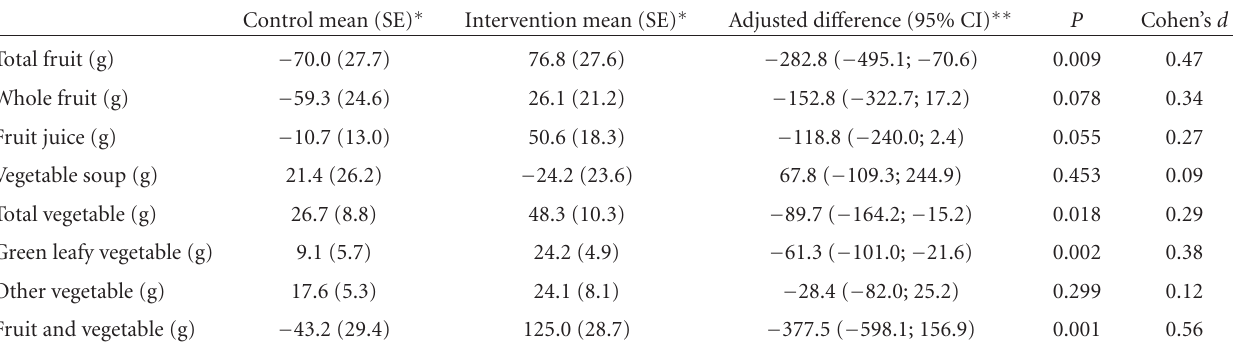
Table 2: Di ff erences between intervention and control schools on fruit and vegetables consumption at 6-month postintervention